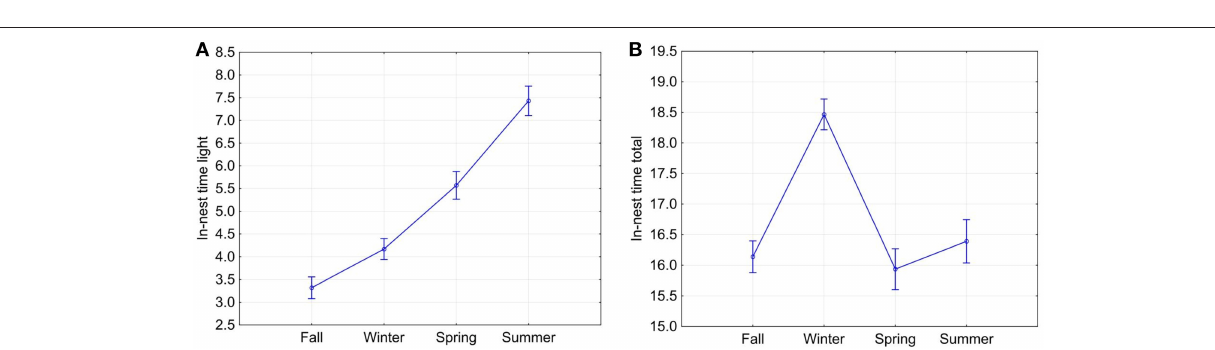
lengths (r) between 0.76 and 0.99. Individual squirrels